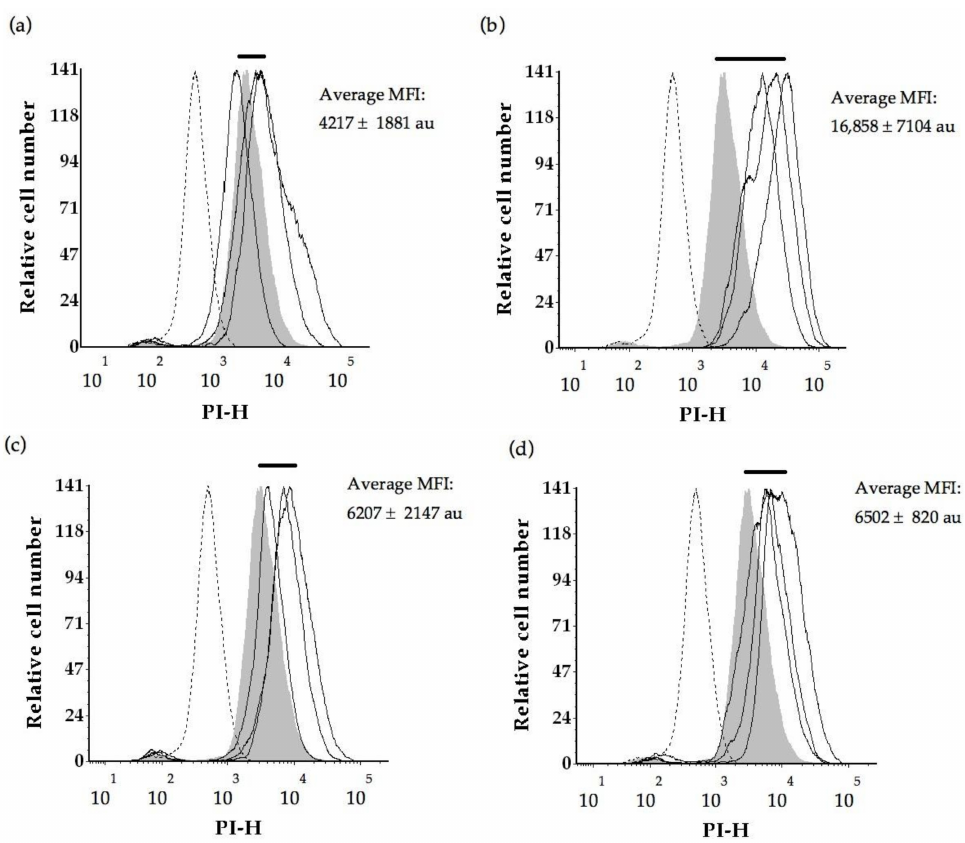
Figure 4. Propidium iodide fluorescence intensities measured for yeast cells at tirage (time 0). Solid bar represents the shift in PI intensities with respect to the labelled control, dotted line represents the unlabelled control, shaded area represents the labelled control, solid lines represent yeast replicates from ( a ) the control, ( b ) microwave treatment, ( c ) ultrasound treatment and ( d ) β -glucanase enzyme treatment. MFI denotes median fluorescence intensity of PI stained S. cerevisiae cells and PI-H denotes propidium iodide fluorescence peak